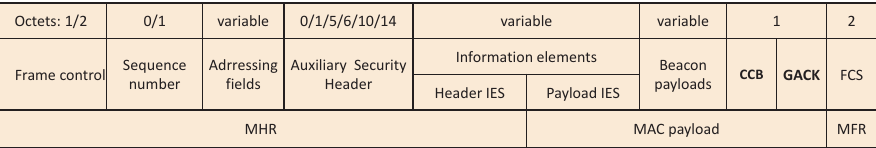
Figure 2. A new beacon frame for IEEE802.15.4e.